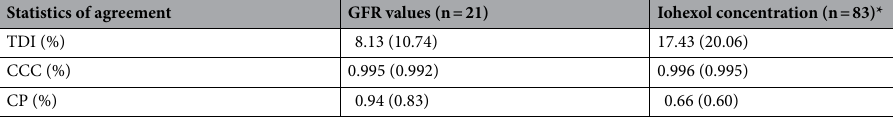
Table 2. Agreement analysis between the values of glomerular filtration rate values and iohexol concentrations measured by the tested method—DBS—and the reference method—total blood. GFR: glomerular filtration rate, TDI: total deviation index; CCC: concordance correlation coefficient; CP: coverage provability. Upper CI: confidence interval is given for all values. *Points with large deviation from the curve are not